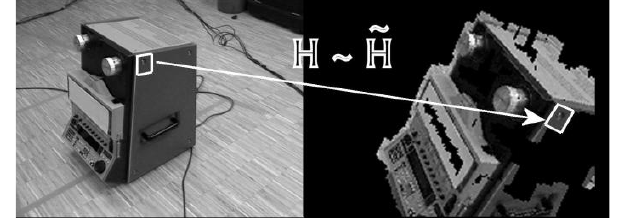
Figure 11. Intermediate image (right) generated from a keyframe (left). 4) Interest point extraction and matching: The Harris